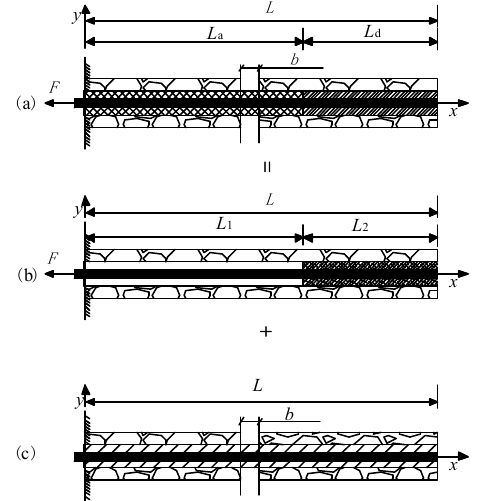
Figure 2. Analytical model of the full-length bonded prestressed bolts. ( a ) full-length bonded prestressed bolt; ( b ) end-anchored prestressed bolt; ( c ) full-length bonded unprestressed bolt.